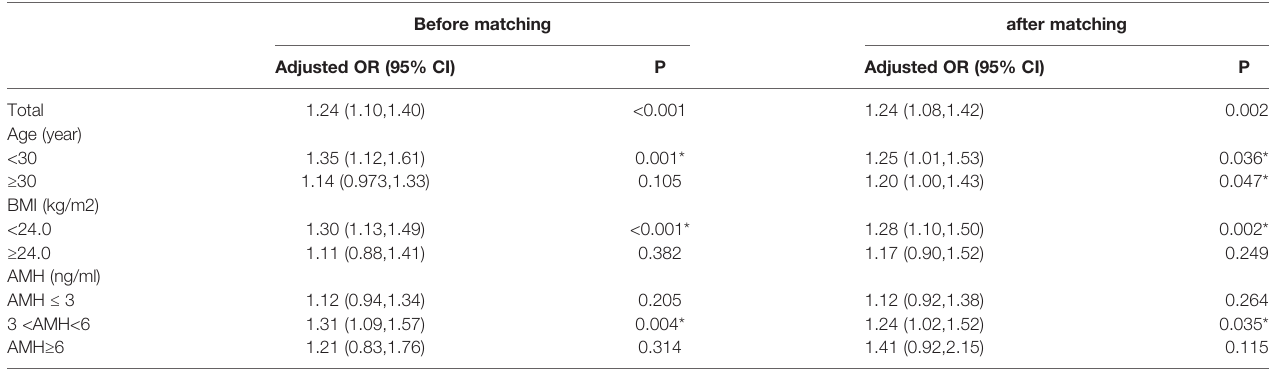
TABLE 3 | Comparison of live birth rate of the GnRH agonist long-acting protocol and GnRH antagonist protocol using multivariable logistic regression analysis in subgroup women with different BMI, AMH and age and after PS matching. (the GnRH antagonist protocol as a reference). Before matching after matching